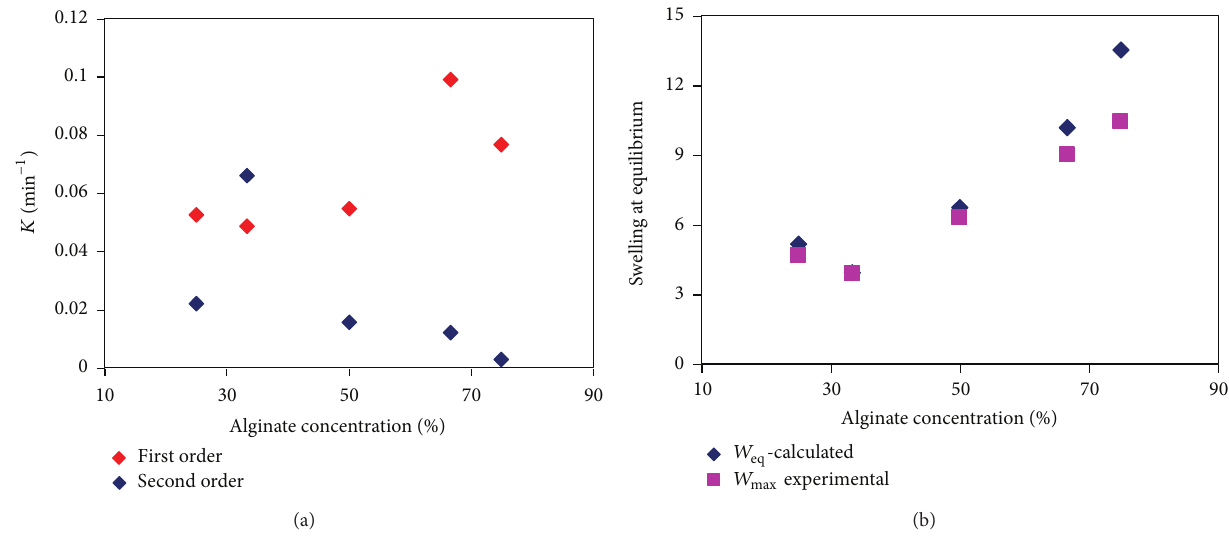
Figure 7: Plot of (a) swelling rate constant (𝐾) of the first and second order kinetic against the alginate concentration of hydrogel films chemically cross-linked; (b) water content at equilibrium calculated 𝑊 concentration of hydrogel films chemically cross-linked.